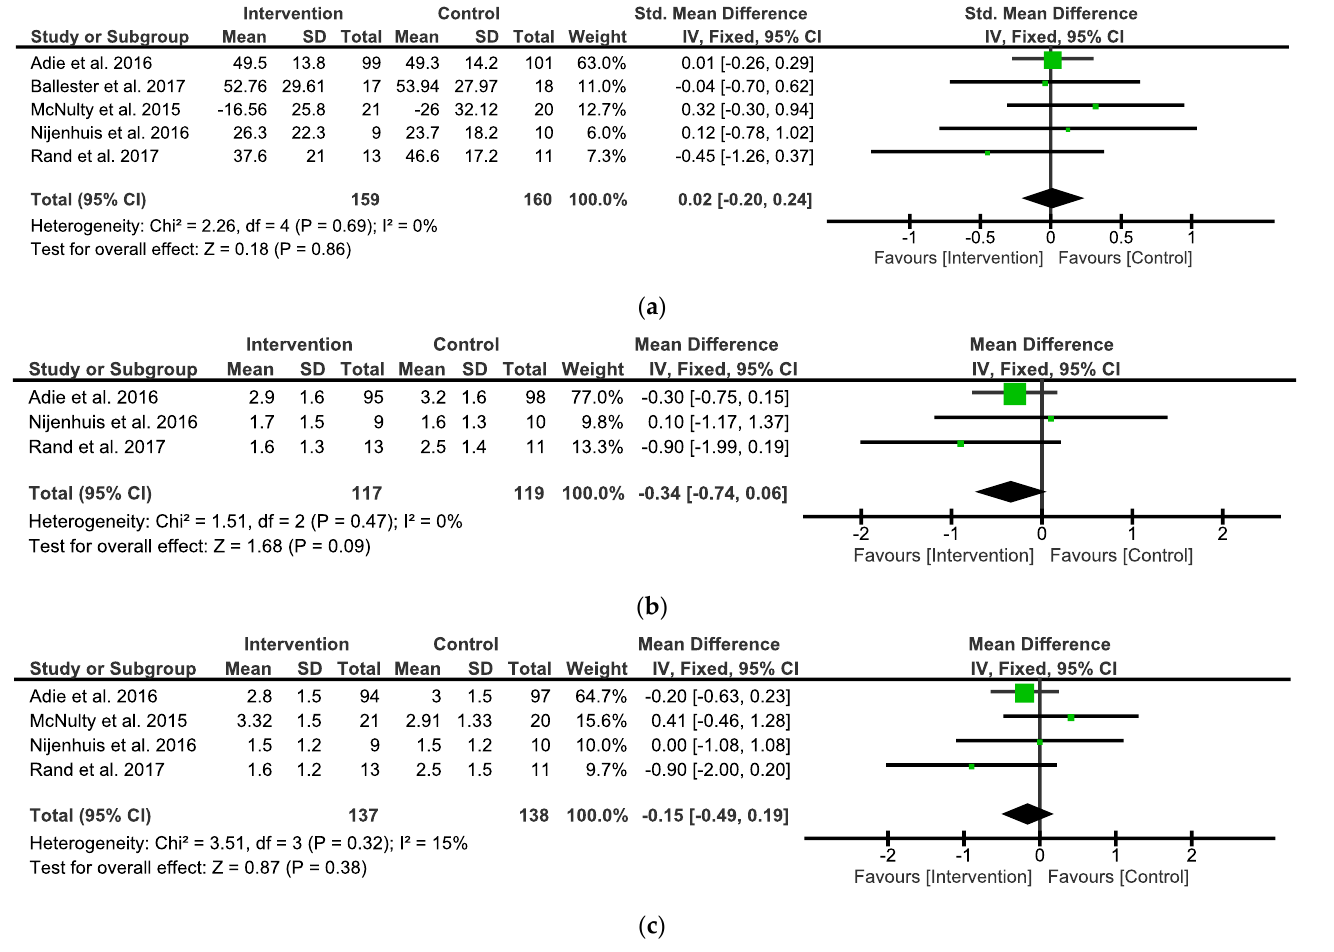
Figure 3. Forest plot between Intervention and Control Groups in follow-up. ( a ) SMD for the observed outcome; ( b ) MD for the self-reported outcomes MALAOU; ( c ) MD for the self-reported outcomes MALQOM. A pooled result favoring Intervention Group indicates negative values, and favoring Control group indicates positive differences between Intervention and Control Groups.